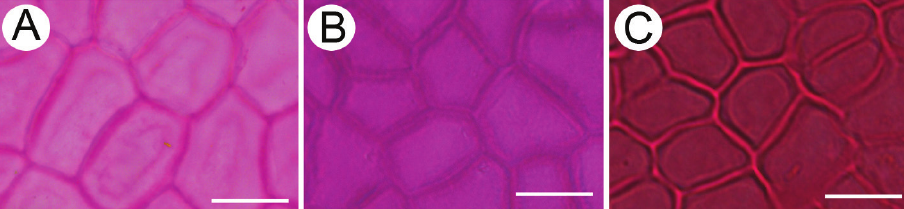
Figure 6. Leaf epidermal micromorphology of Sassafras displaying the non-reticulate periclinal wall in the genus A S. albidum B S. randaiense C S. tzumu . Scale bars: 20 μm ( A–C